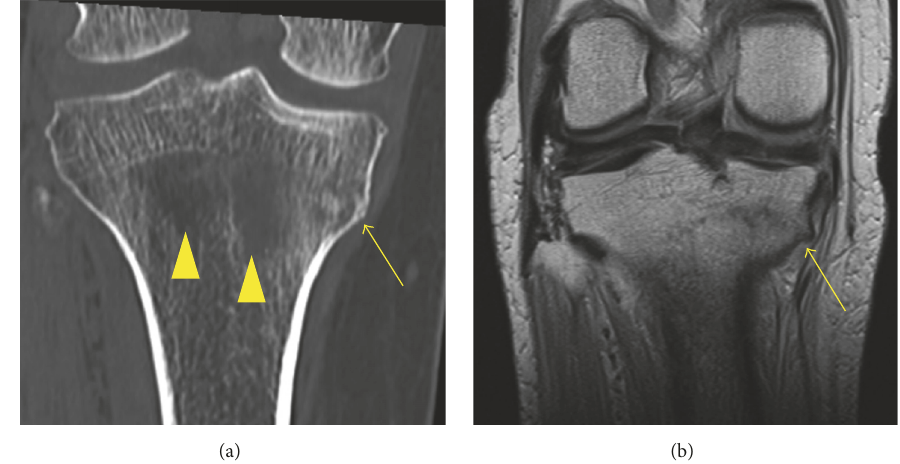
Figure 2: (a) Coronal CT imaging of right knee shows irregularity of cortex in the proximal medial tibia (yellow arrow) with trabecular bone resorption in the central part of the proximal tibia (yellow arrow heads), which indicates osteomalacia. (b) Coronal T1 weighted MR imaging of right knee shows linear low intensity lesion at the proximal medial tibia (yellow arrow), which indicates insufficiency fracture.